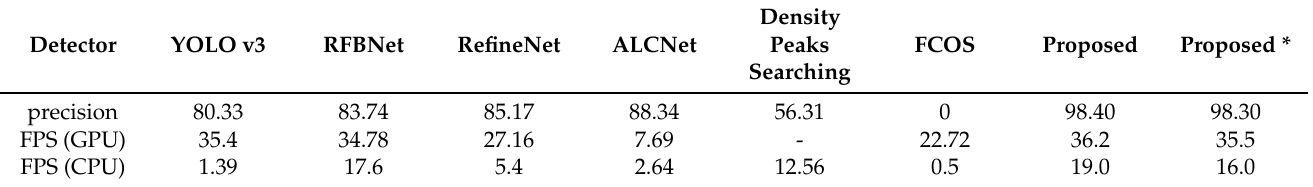
Table 4. Comparison of detection results between comprehensive methods and other deep- learning